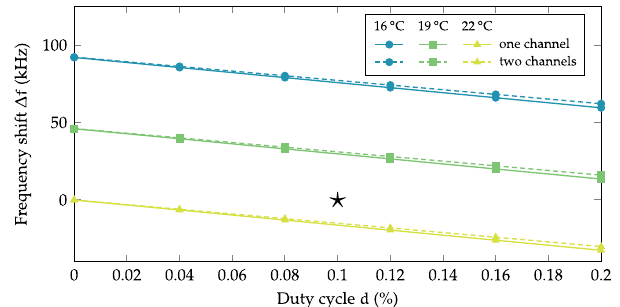
FIG. 29. Resonance frequency shift Δ f of the RFQ cavity subject to heat-induced deformation as a function of duty cycle d and cooling water temperature T for the cases of one and two w cooling channels per vane. At nominal operation, the heating is compensated by reducing T by 1 K ( w